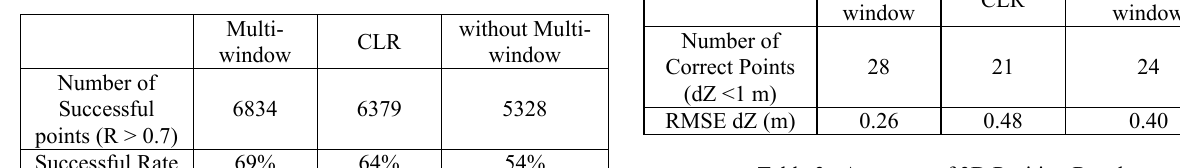
Table 3. Accuracy of 3D Position Results